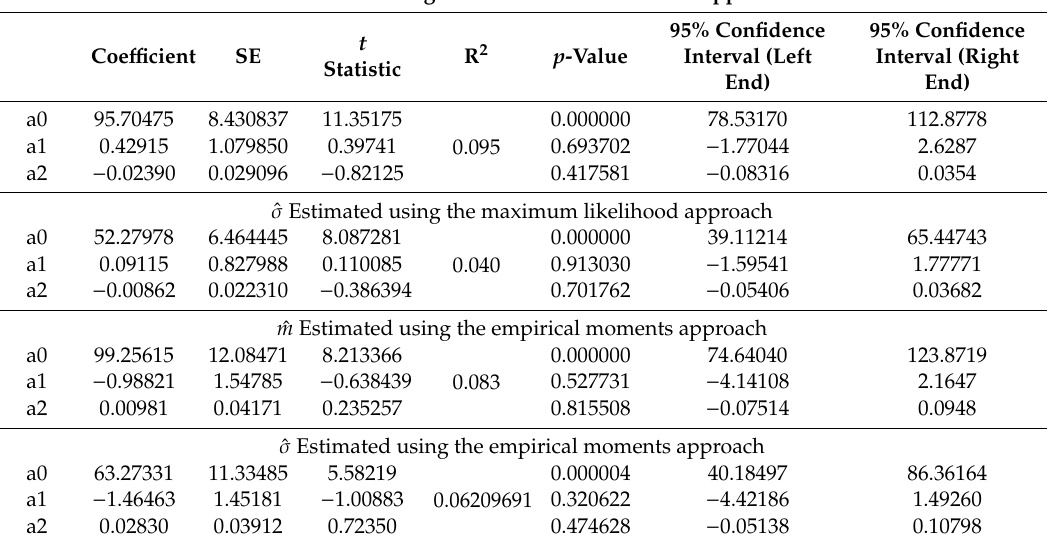
Table 3. Evaluation of the estimated models achieved using the Gauss–Newton method with a maximal number of iterations: